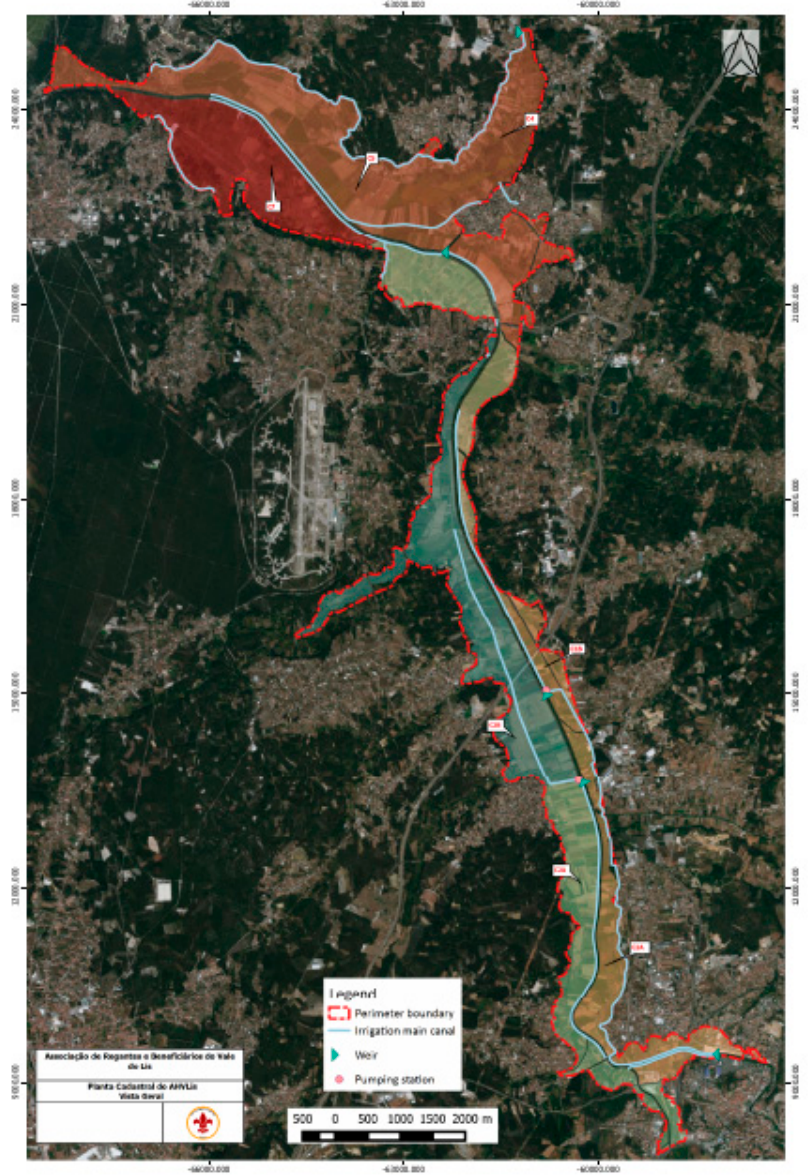
Figure 2. Location of supply sectors in Lis Valley Irrigation District (Source: Lis Valley Water Users’ Association (WUA)).